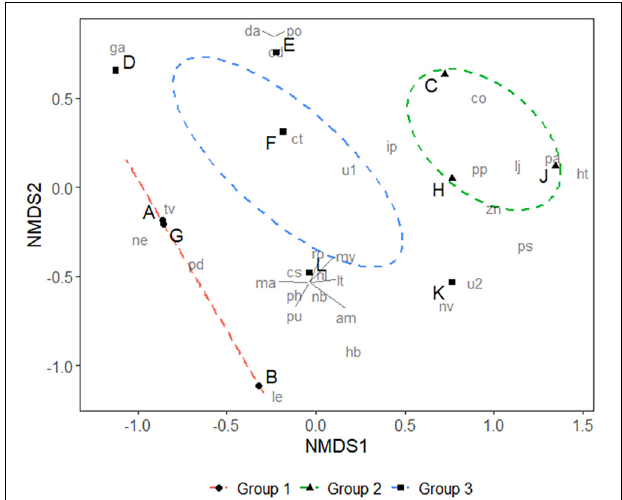
FIGURE 4 | Non-metric Multidimensional Scaling (NMDS) of prey animals of larval and juvenile L . polyactis. Stress = 0.09, and confidence limit for the ordination ellipse is 90%. Analysis of similarity (ANOSIM) on three groups: R = 0.34, P < 0.05. Group 1 represents animals with an average body length < 17 mm (post-larva); Group 2 represents animals between 17 and 19 mm (post-larva or juvenile at the transitional stage); Group 3 represents animals > 20 mm